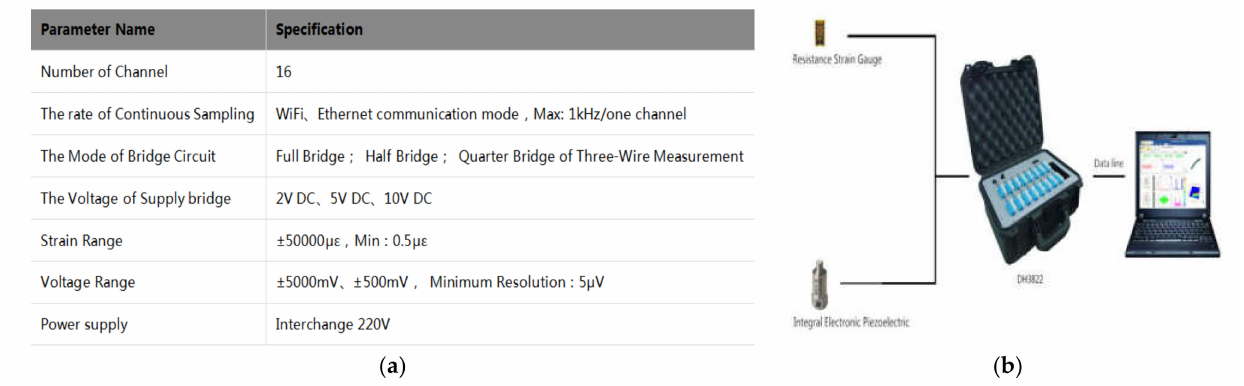
Figure 3. Partial parameters and connection methods of DH3822. ( a ) Parameter; ( b ) Connection